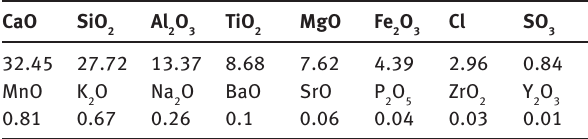
Table 2: Chemical composition of EBFS samples